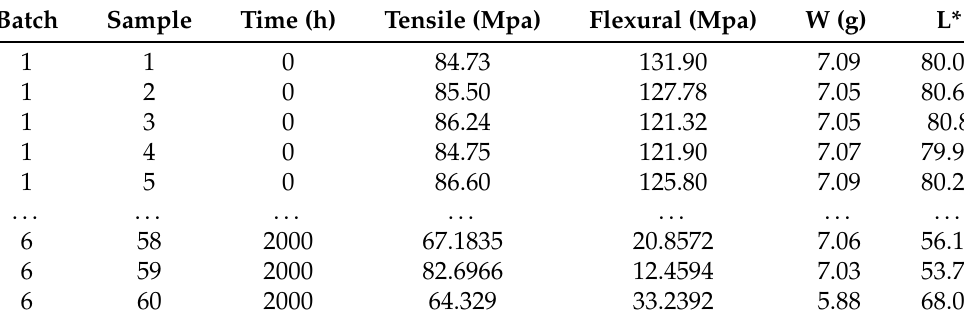
Table 1. Accelerated degradation test